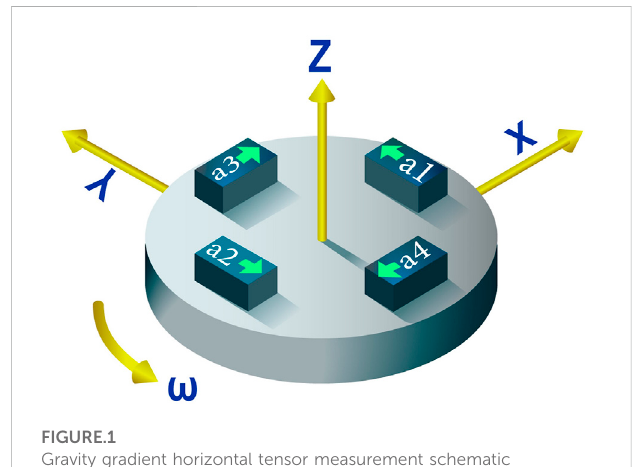
FIGURE.1 Gravity gradient horizontal tensor measurement schematic diagram.